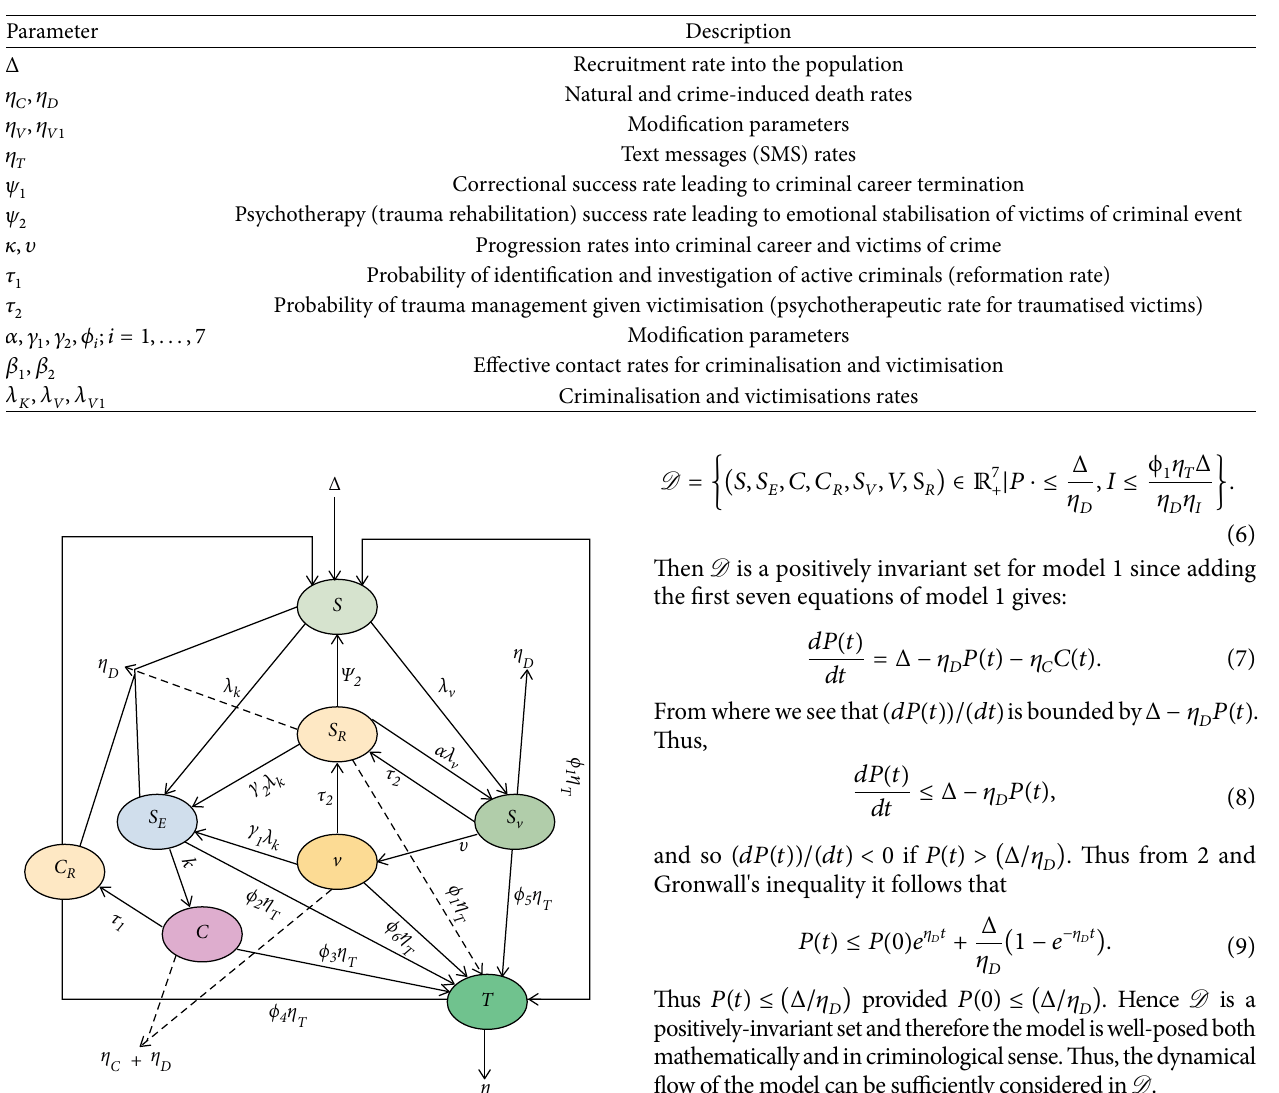
Table 2: Parameters for the crime model and their various descriptions.